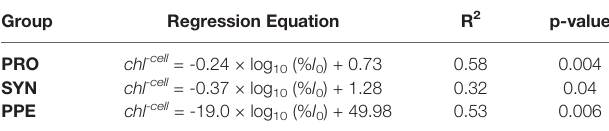
P-values correspond to ANOVA test comparing the ratio of model residuals to differences between regression estimates and mean per-cell Chl a for each